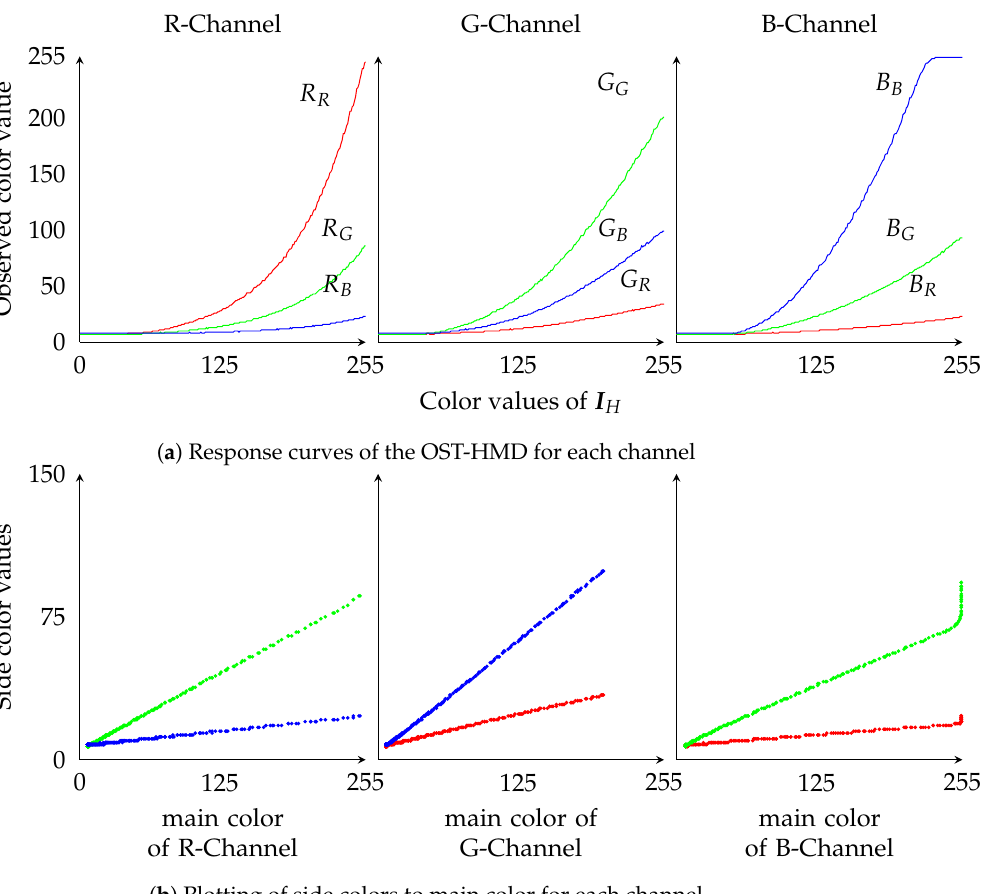
Figure 9. Response curves of the user perspective camera to the OST-HMD rendered